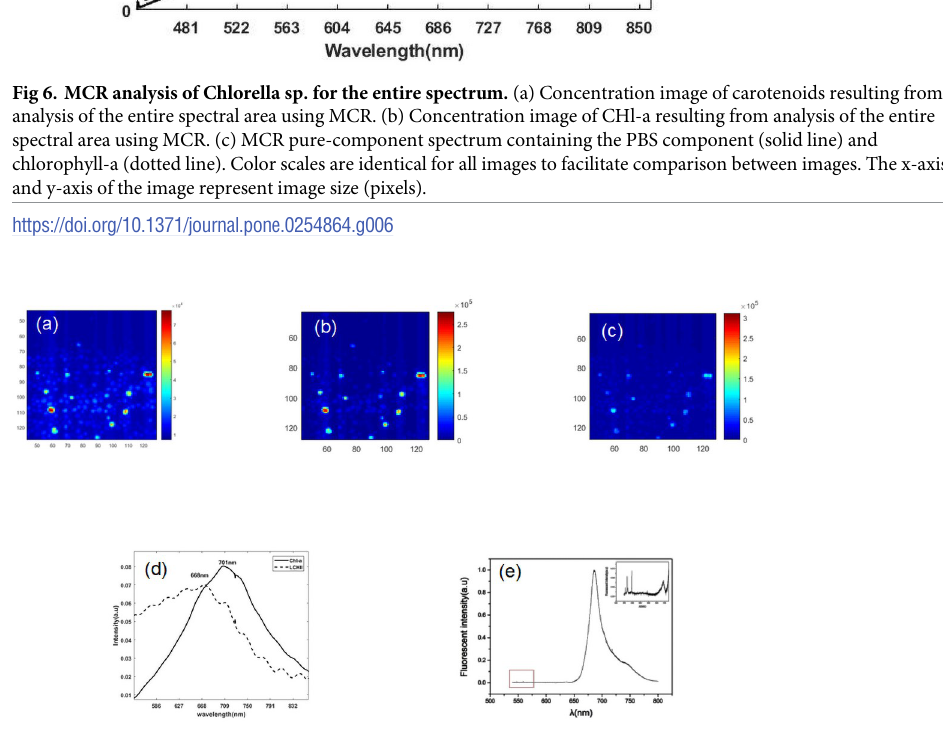
Fig 7. MCR analysis of Chlorella sp. for spectrum selection. (a) Concentration images for Chlorella sp. of carotenoid resulting from analysis of selective spectral area (470–574 nm) (b) Concentration images of Chlorophyll a (c) Concentration images of Light-Harvesting Complex II(LCH-II). (f) pure component spectrum of Chlorella sp. representing chlorophyll a (solid line) and light-harvesting complex II (dotted line) (e) Emission measurement under pigment extraction above 574 nm excited at 512 nm (ex: 512 nm). This describes the intensity difference between carotenoid and chlorophyll spectral areas.